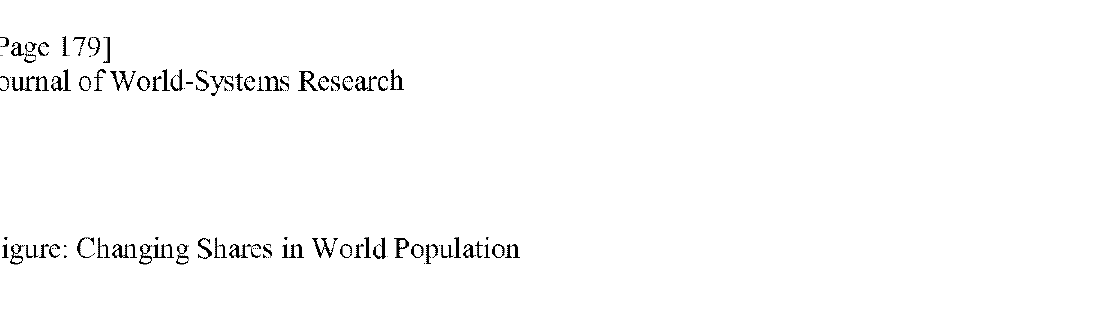
Figure: Changing Shares in World